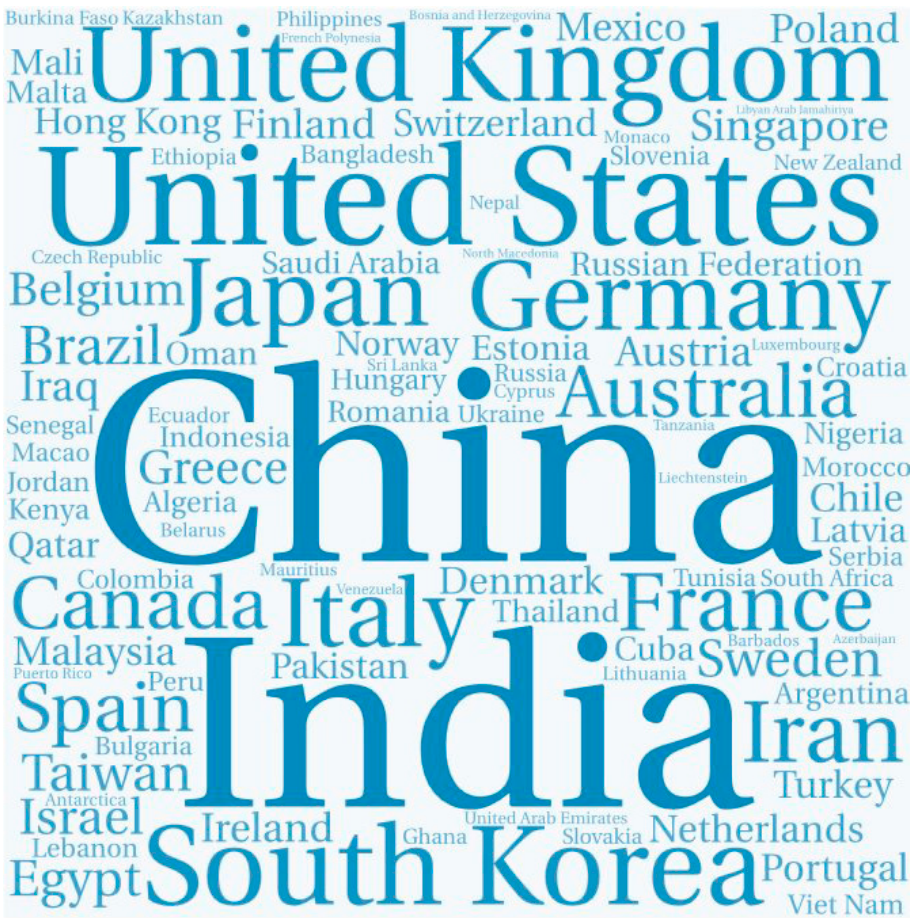
Figure 2. Word cloud chart of the authors’ affiliations. The different font sizes of the countries are proportional to the number of publications. The position of the country in this visual map is ran- domized.